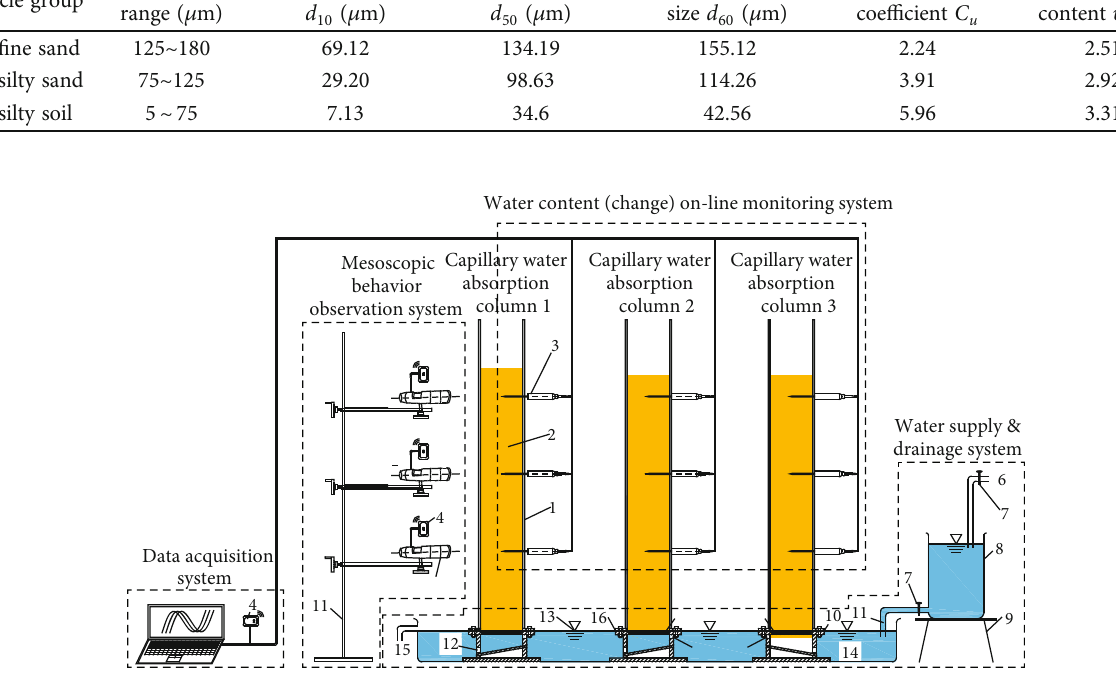
Figure 3: The schematic diagram of OM-CRT system. 1 — tube wall; 2 — tailings; 3 — water sensor; 4 — cloud module; 5 — distortionless microscope; 6 — water source; 7 — valve; 8 — water storage tank; 9 — trestle; 10 — porous disk; 11 — constant speed water supply pipe; 12 — scupper and outlet pipe; 13 — constant water lever; 14 — water-in; 15 — water-out; 16 — geotextile.